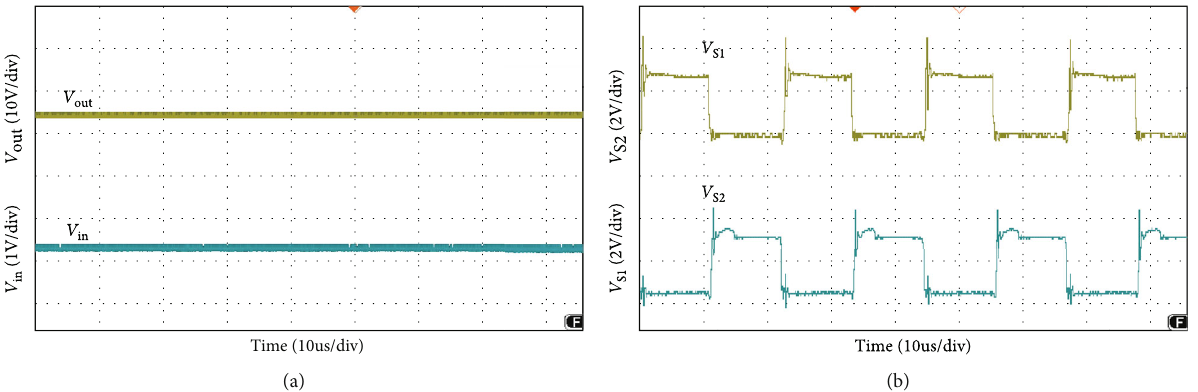
Figure 16: Stress wave form of input/output voltage and switches voltage.